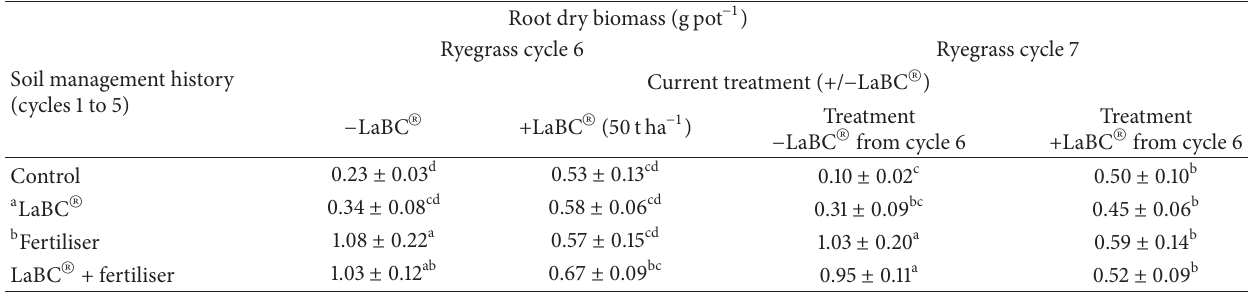
Table4:Rootdrybiomass(g pot − 1 )inryegrasscycles6and7withreappliedLaBC Ⓡ (+/ − )asinfluencedbyresidualeffectsofsoilamendments from previous management history.